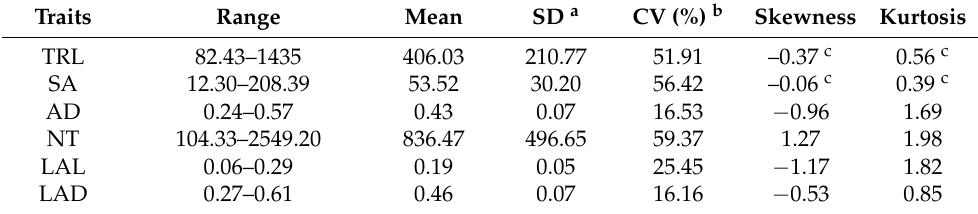
Table 1. Descriptive statistics for six root traits in 61 adzuki bean accessions.